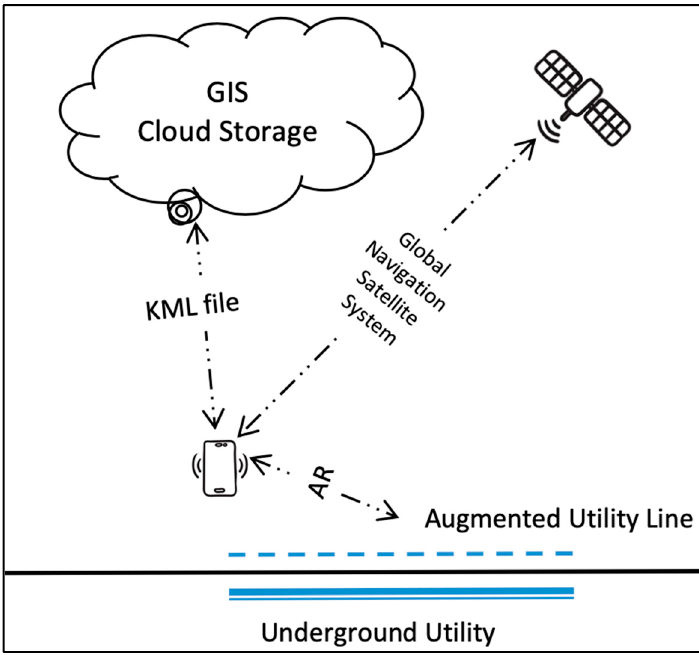
Figure 3. Augmented reality workflow development.